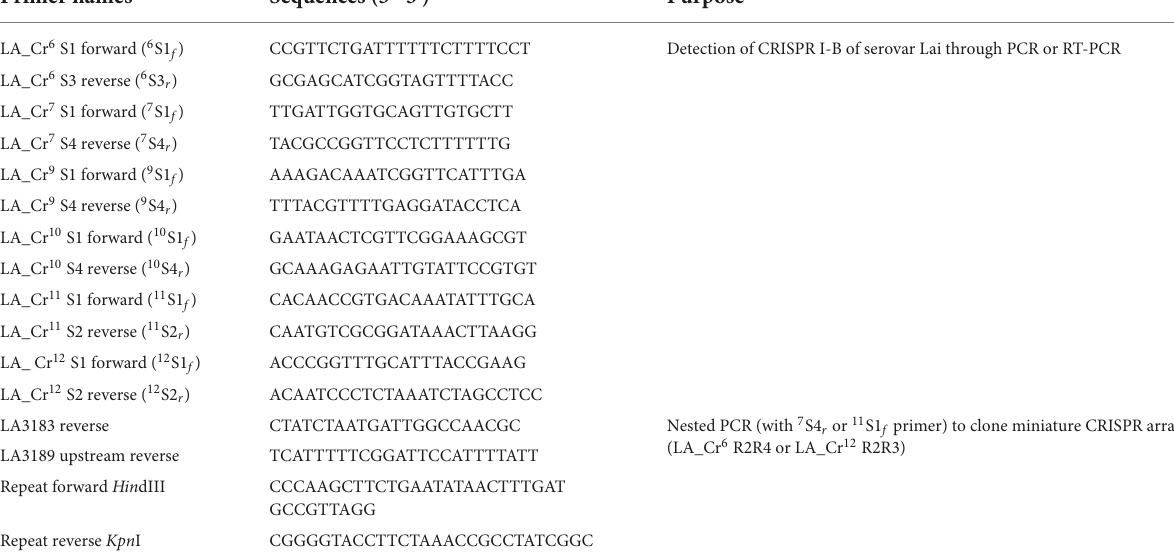
TABLE 1 Oligos used in this